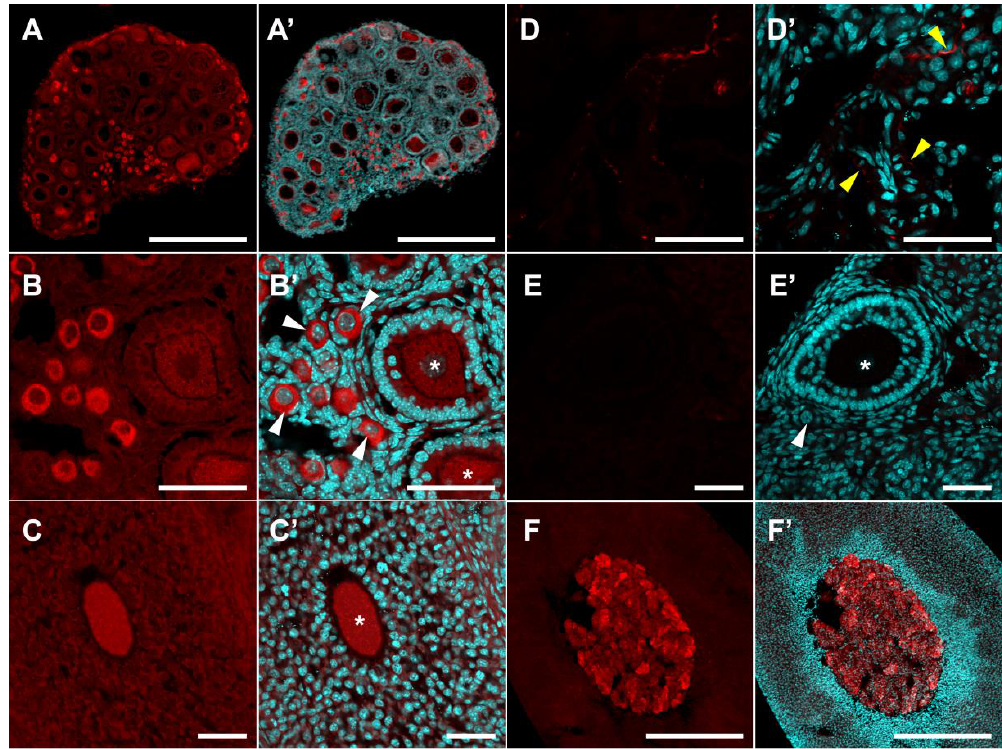
Figure 3. Immunohistochemical detection of DDC in the mouse ovary. ( A–D ) DDC immunoreactivity in the ovary of prepubertal ( A, B, D ) and adult mice ( C ). ( E ) Negative control: Ovary immunostaining without primary antibodies. ( F ) Positive control: Adrenal gland with DDC immunoreactivity in the medullar region. ( A’–F’ ) Images merged with nuclear staining. Twenty-μm cryosections were stained for DDC (red false colour) and nuclei were dyed with DAPI counterstain (cyan false colour). White arrowheads point to primordial follicles. Asterisks mark oocytes in growing follicles. Yellow arrowheads point to nerve fibres in ovarian stromal tissue. Scale bars: ( A , F ) 500 µm; ( B – E ) 50 µm.